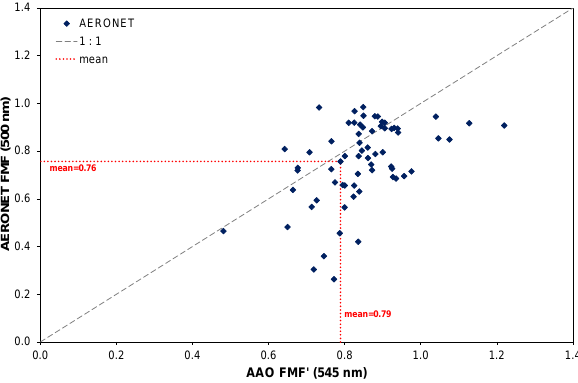
Fig. 5. Comparison of AAO aircraft calculated submicrometer Mode Fraction (at 545nm) with AERONET Fine Mode Fraction (at 500nm).